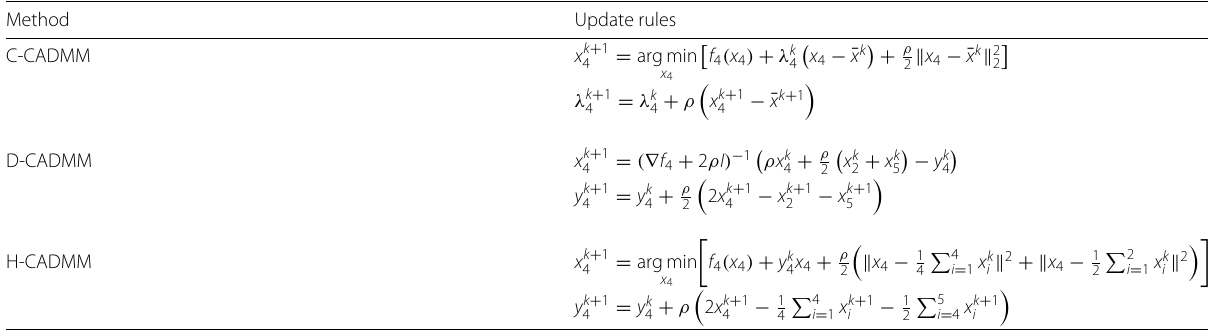
Table 1 Comparison of ADMM update rules at node 4 using C-CADMM, D-CADMM, and H-CADMM to solve the problem in Example